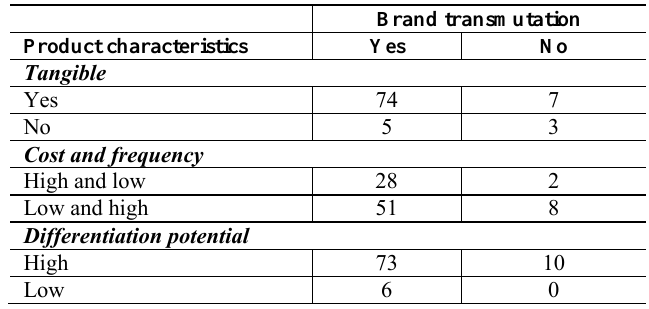
table. A short description of the methodologies of Fisher’s exact test and the log linear model follows